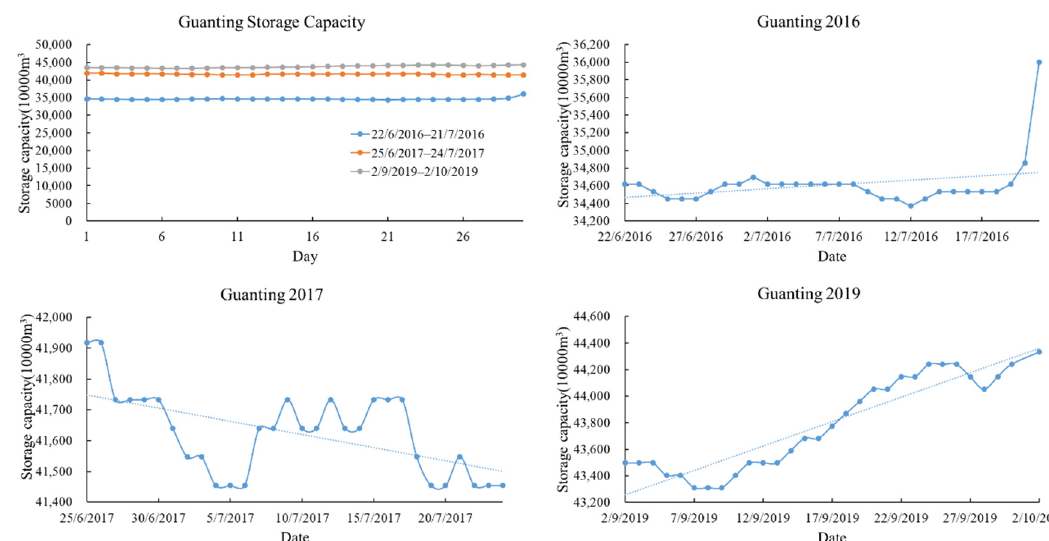
Figure 8. Water storage of the Guanting Reservoir within 30 days before and after retrieval date. From 2016 to 2017, the capacity of the reservoir increased. It had the largest capacity in 2019. From 25 June to 24 July, 2017, the daily variation of the reservoir capacity is large.